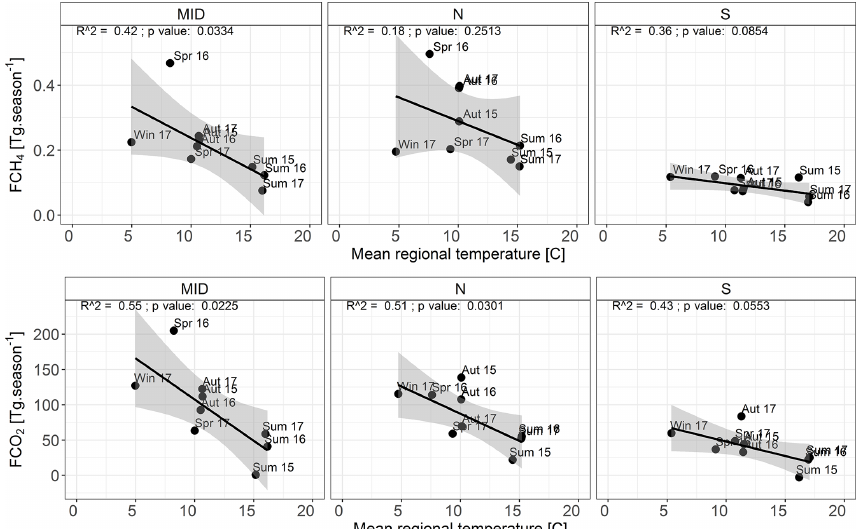
Figure 13. Seasonal fluxes of CH 4 and CO 2 estimated by mass balance from concentration measurements on board the ferry as a function of mean regional air temperature (source: Met Office, 2018). The data are presented for three latitudinal regions denoted MID, N, and S. The MID region spans the latitude range 52.8–54.2 ◦ N, N spans 54.2–56.1 ◦ N, and S spans 52.0–52.8 ◦ N. The shaded area represents the 95% confidence intervals of the linear